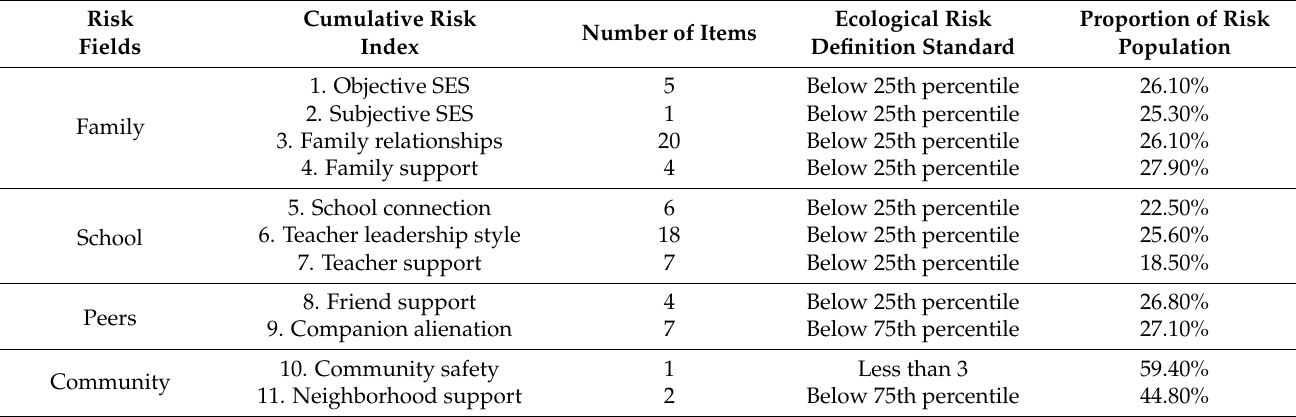
Table 1. Descriptions and Definitions of Cumulative Ecological Risk